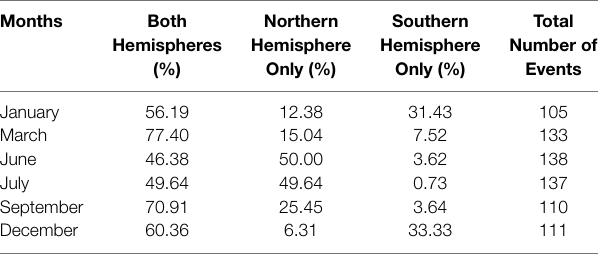
TABLE 1 | Table showing the ratio of occurrences of R2Bs in the months of January, December (southern summer solstice), March, September (equinox), and June, July (northern summer solstice).